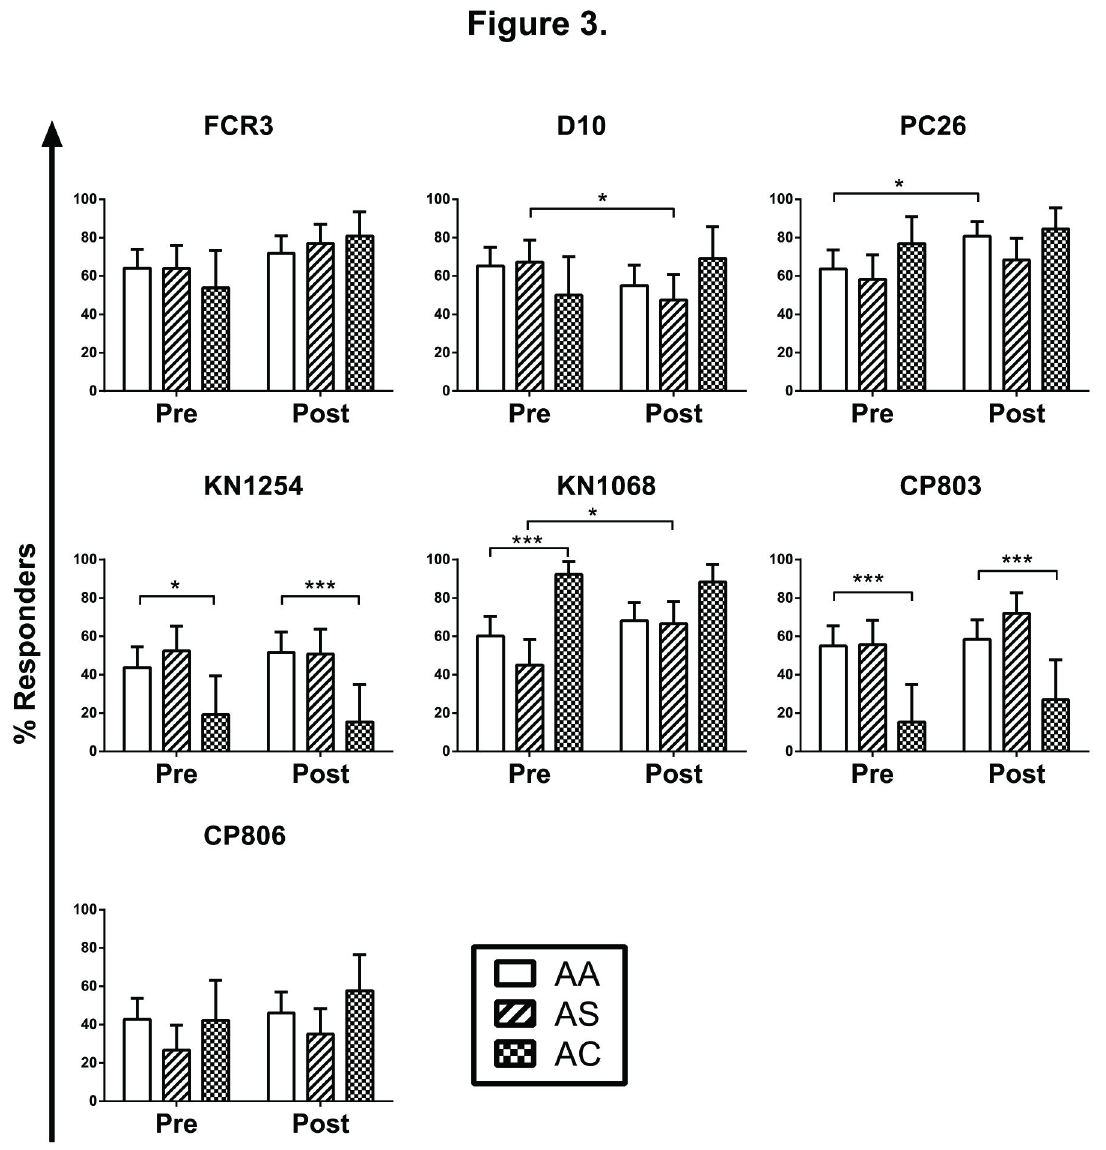
Figure 3. Effect of Hb type on IgG recognition of different parasite strains. The proportions of children responding to each parasite strain were compared between Hb types, before and after the transmission season. The age effect at each time point was evaluated using Chi-square likelihood ratio test; significant findings were then confirmed by Odds ratio test. The seasonal effect of each Hb type was evaluated using Fisher’s exact test. *p<0.05, **p<0.01, ***p<0.001. Error bars shown are the upper 95% Confidence Interval for the % responder